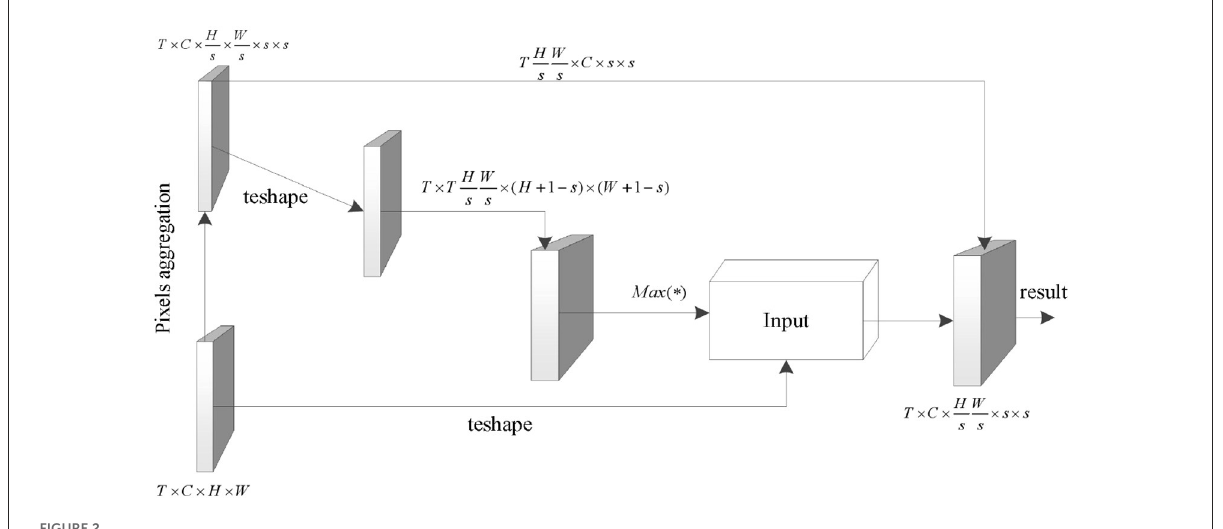
FIGURE2 Structure of MLDC algorithm.